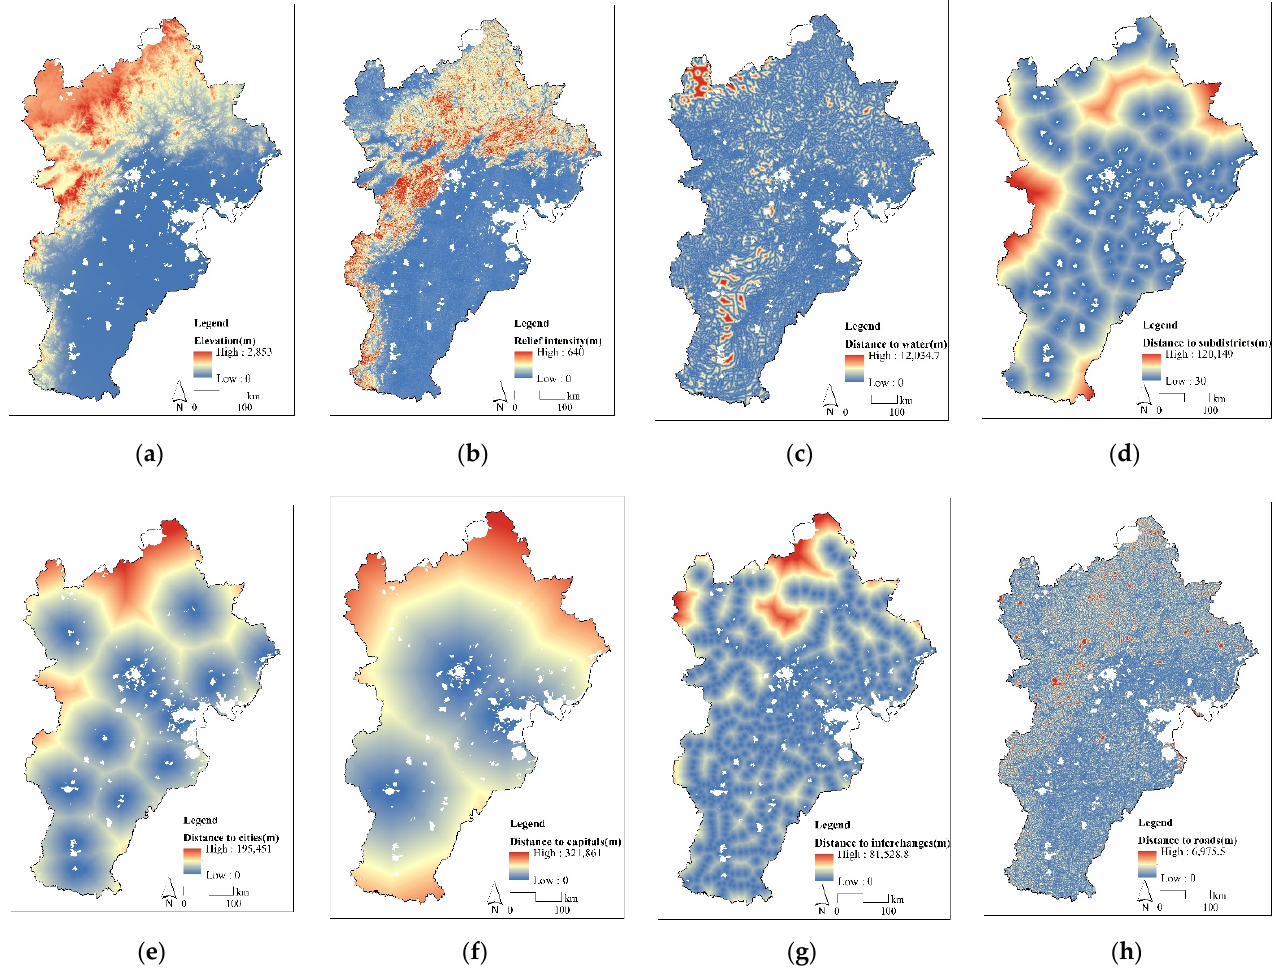
Figure 3. Distributions of factors. ( a ) Elevation distribution, ( b ) distribution of relief intensity, ( c ) distance to water, ( d ) distance to subdistricts, ( e ) distance to cities, ( f ) distance to capitals, ( g ) distance to interchanges, ( h ) distance to roads.